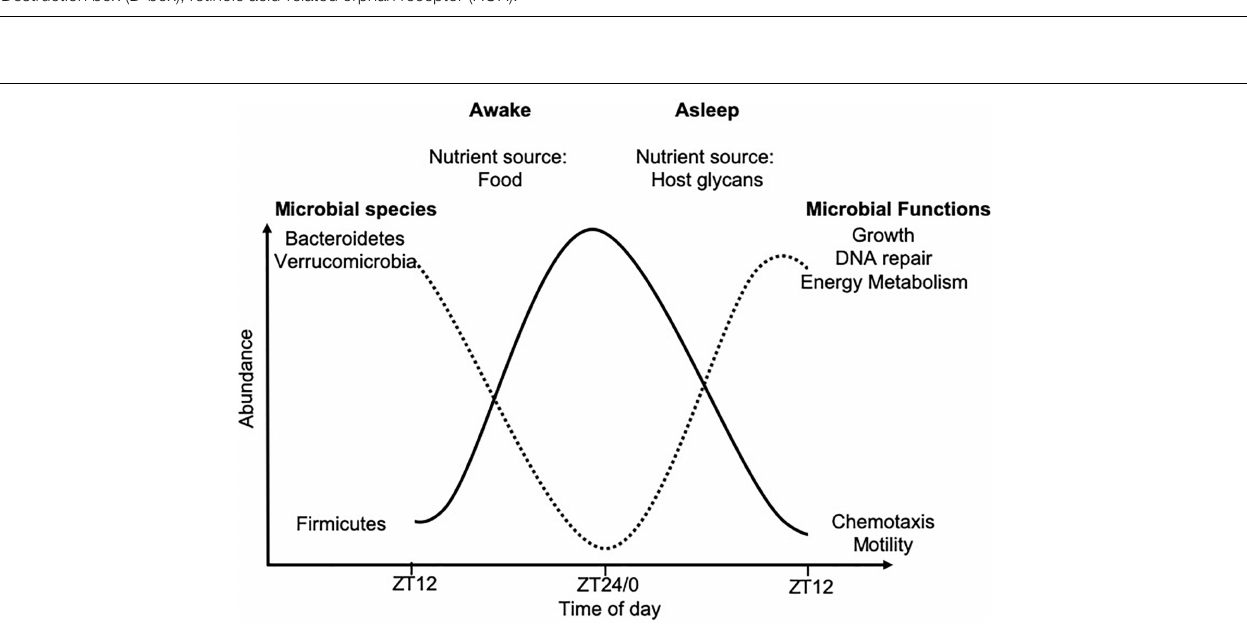
Frontiers in Microbiology |